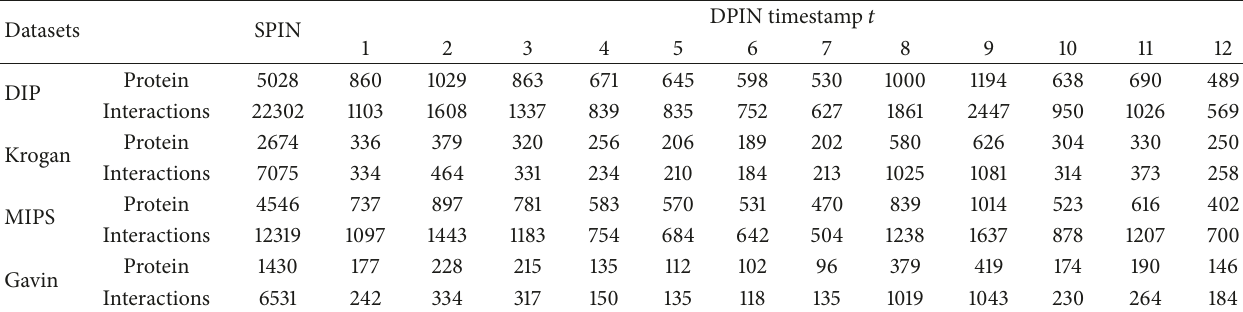
Table 1: The number of proteins and interactions in SPIN and DPIN on four datasets.